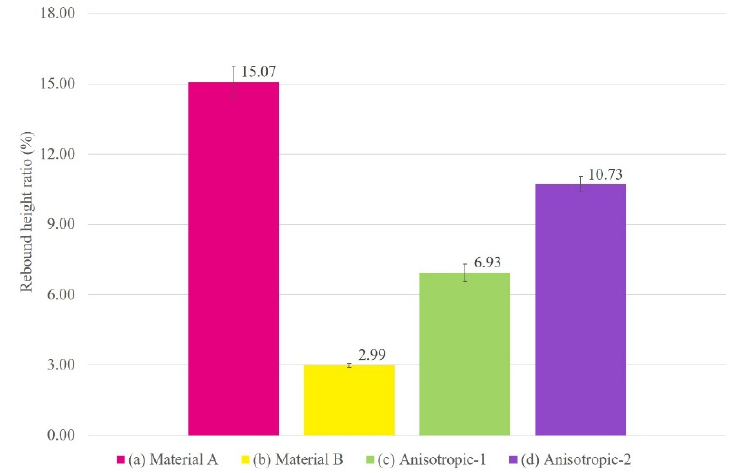
Figure 16. Average rebound height ratios of the anisotropic structures.